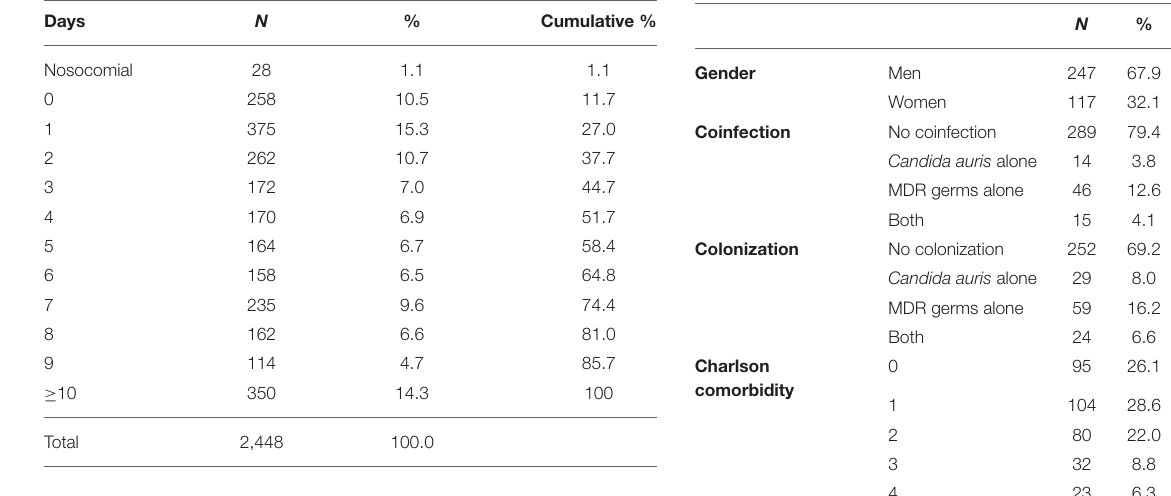
TABLE 3 | Characteristics of patients admitted to the ICU for COVID-19, February 2020 to February